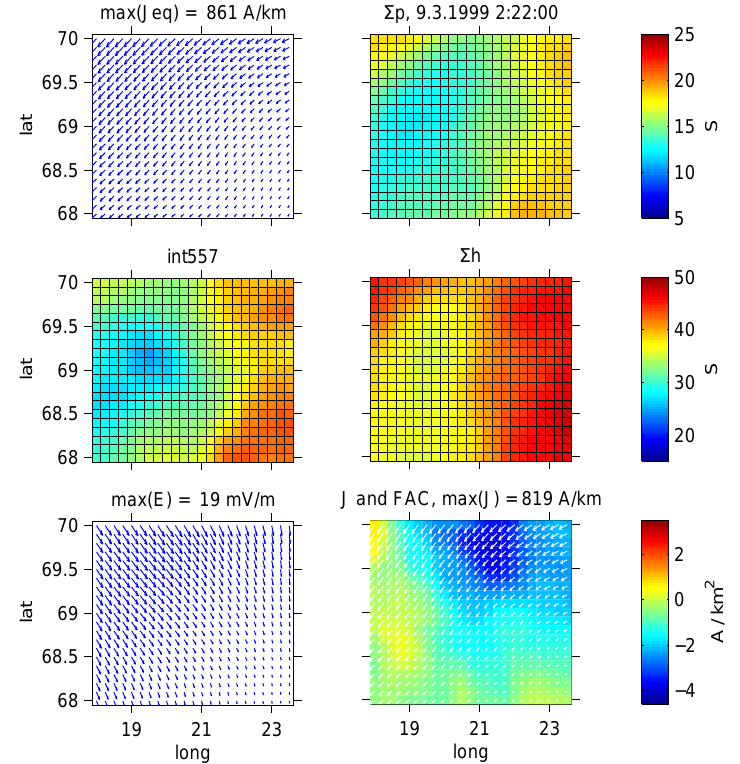
Fig. 9. Similar to Fig. 7, but for